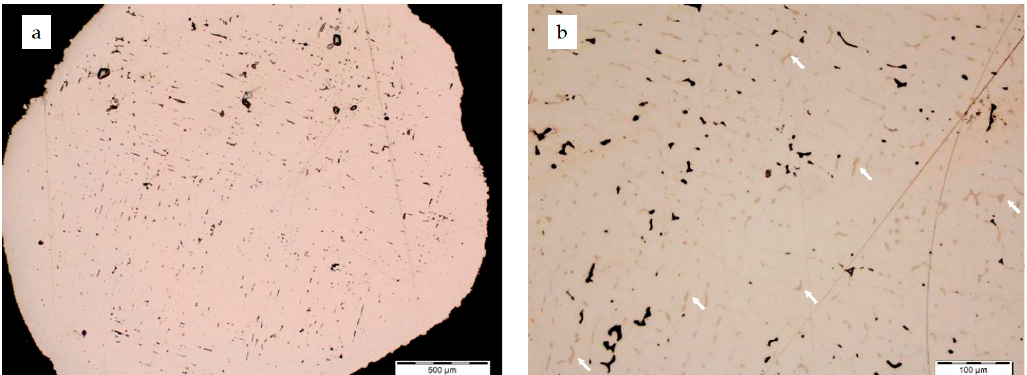
Figure 21. Optical microscope images of the examined prill. ( a ) is a low magnification image. ( b ) (high magnification) shows the presence of two phases. The bulk of the prill consists of a Pt,Ni-rich alloy (light colored), while the brownish phase (darker colored–arrows) contains the palladium. The black areas are voids.